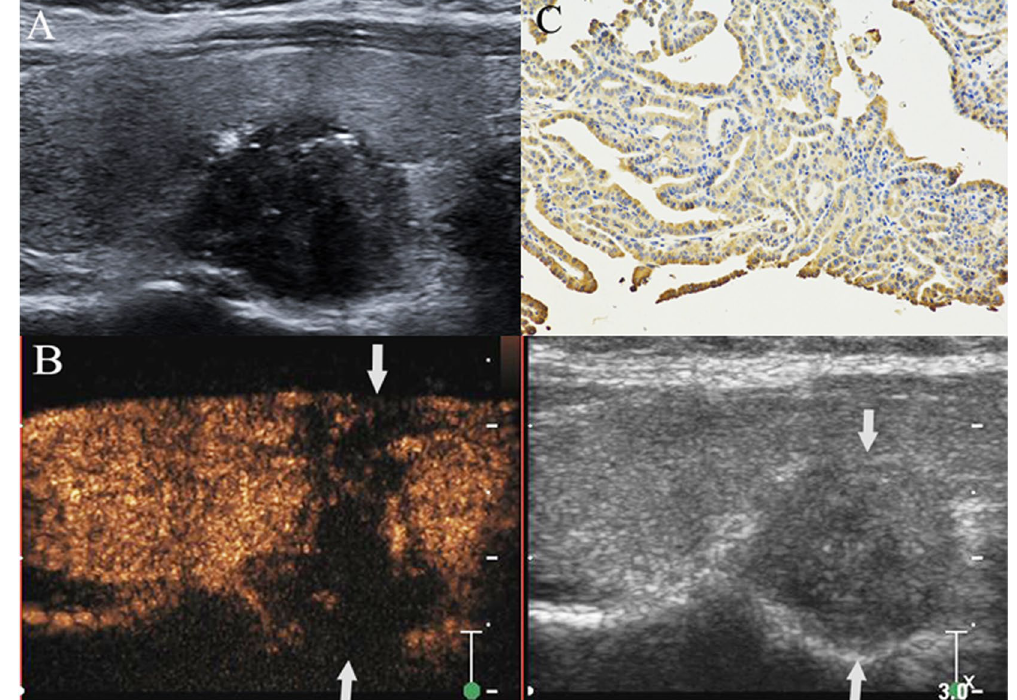
Figure 1. PTC with cervical LNM. A hypoechoic nodule with ill-defined margin, irregular shape and some microcalcifications was found at the lower pole of the right thyroid lobe in a 34- year– old female patient ( A ). The thyroid focal posterior capsular was bulged by nodule. The size of nodule was 1.6 cm × 1.5 cm × 1.0 cm. CEUS showed that a heterogeneous low-enhancement in nodule (left image) and its area (1.8 cm × 1.6 cm × 1.2 cm) was larger than the nodule region displayed on grey-scale image (right image) (arrow). Both the anterior and posterior thyroid capsular were broken and invaded by the nodule (arrows) ( B ). Intense expression ( +++ ) (arrow) of matrix metalloproteinase-9 was found in the cytoplasm of the malignant cells of a PTC sample, as shown by the brown staining (magnification, × 200) ( C ). Surgical results: PTC with ipsilateral region III-V and central compartment region